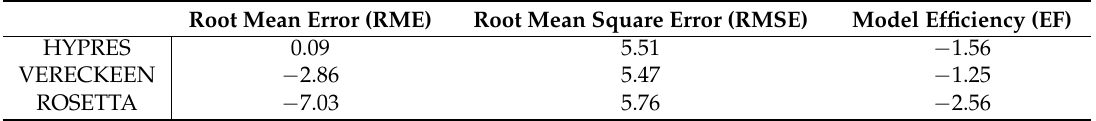
Table 2. Statistics of pedotransfer functions (PTF)s.